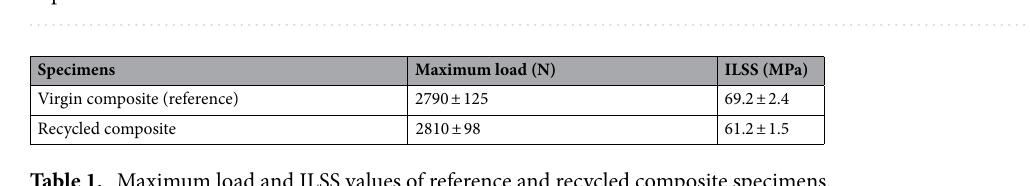
Figure 7. Reference versus recycled composites ( a ) moduli and ( b ) hardness as function of indent penetration depth.